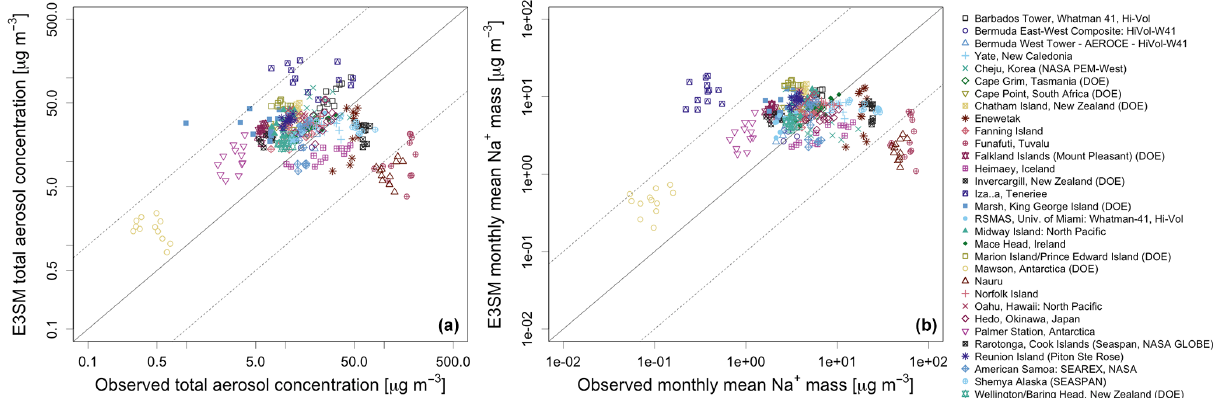
Figure 2. Comparison of monthly means of long-term observations at AEROCE/SEAREX stations with model climatological monthly means at the nearest grid point. (a) Comparison of total aerosol concentration. (b) Comparison of sodium aerosol mass concentration. Because Na is well conserved during transport compared to Cl and sea salt ions, sodium content of modeled sea salt aerosol has been approximated as 30.77% of modeled sea salt